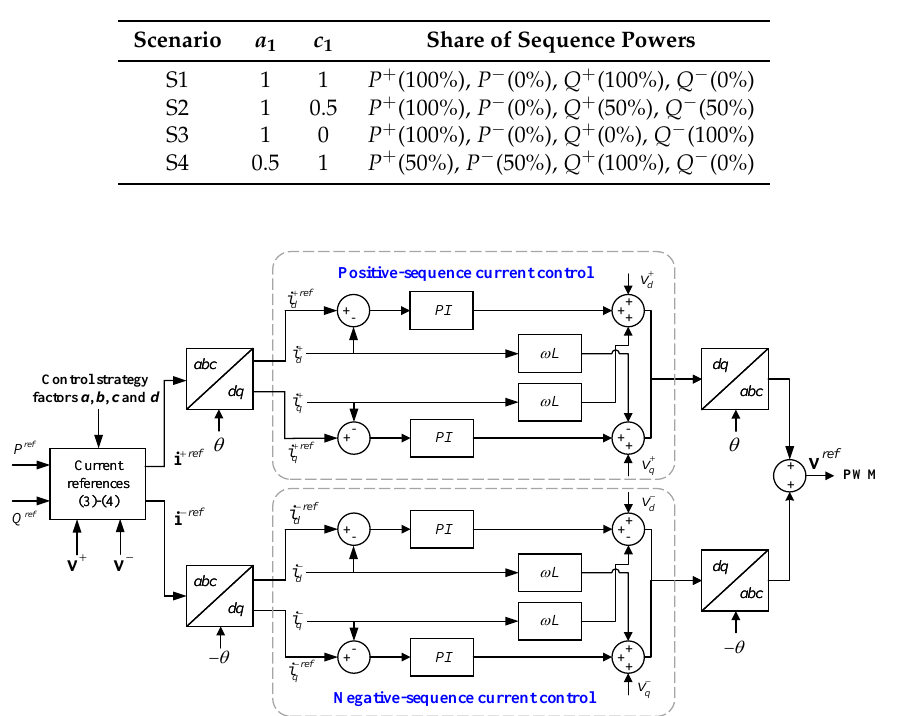
Figure 5. Dual-sequence current control block diagram of the VSC in Real Time Digital Simulator